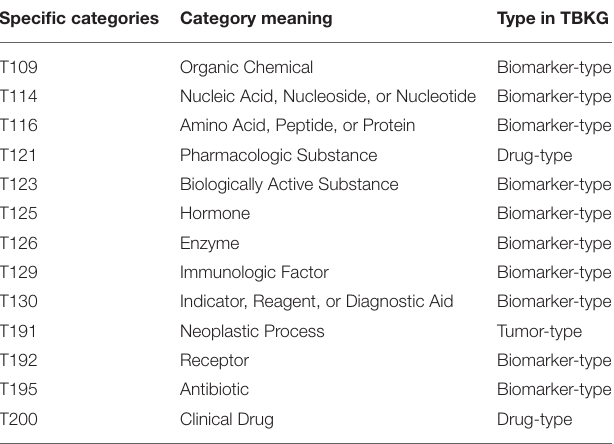
TABLE 1 | The concept category used to build the dictionary. Specific categories Category meaning